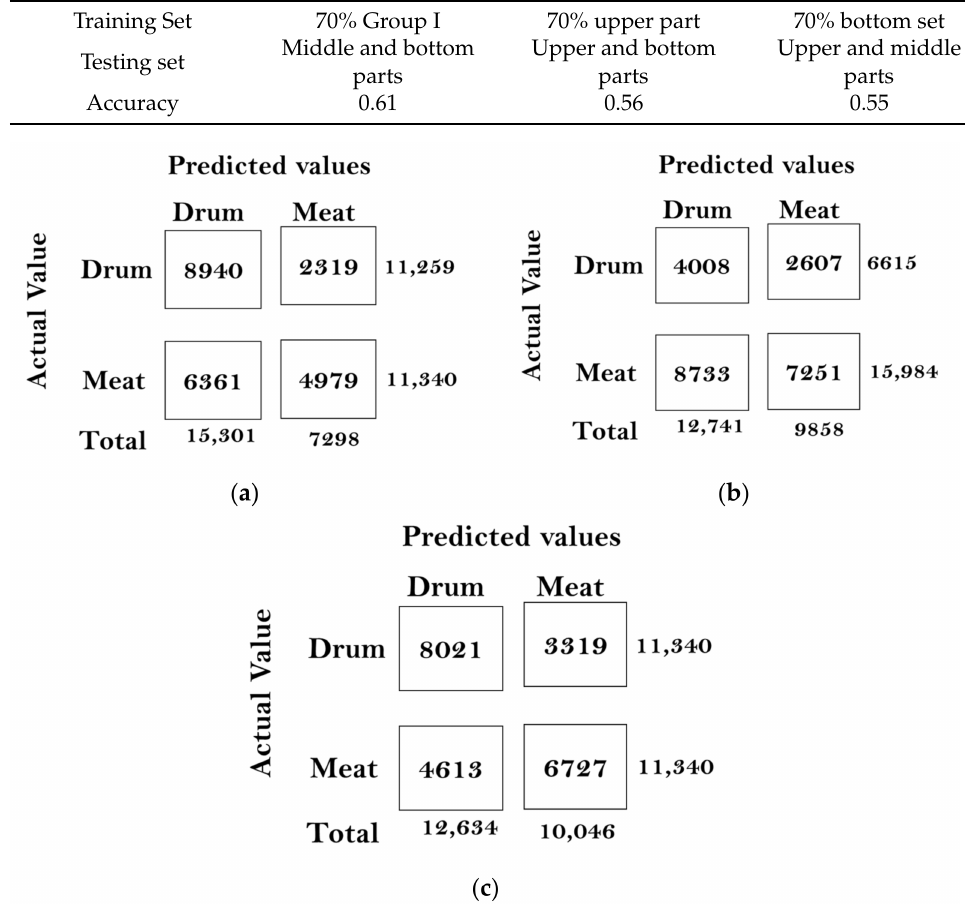
Table 8. Accuracy results of Group I on different parts.